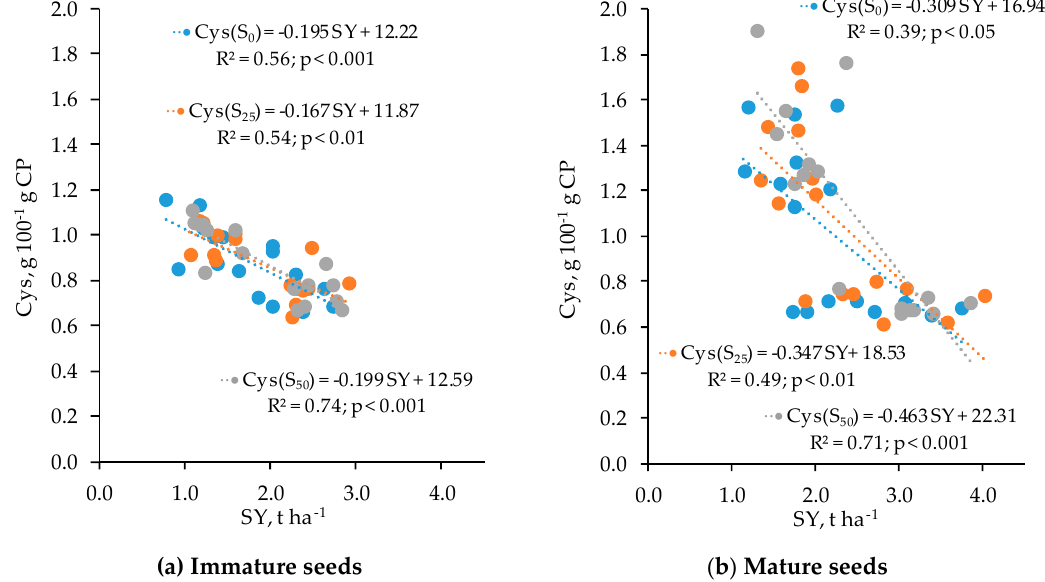
Figure 5. Cysteine (Cys) content as a function of seed yield (SY) at three levels of sulfur application: S 0 , S 25 , S 50 at rates of 0, 25, and 50 kg S ha − 1 , respectively, for: ( a ) immature seeds; and ( b ) mature seeds.